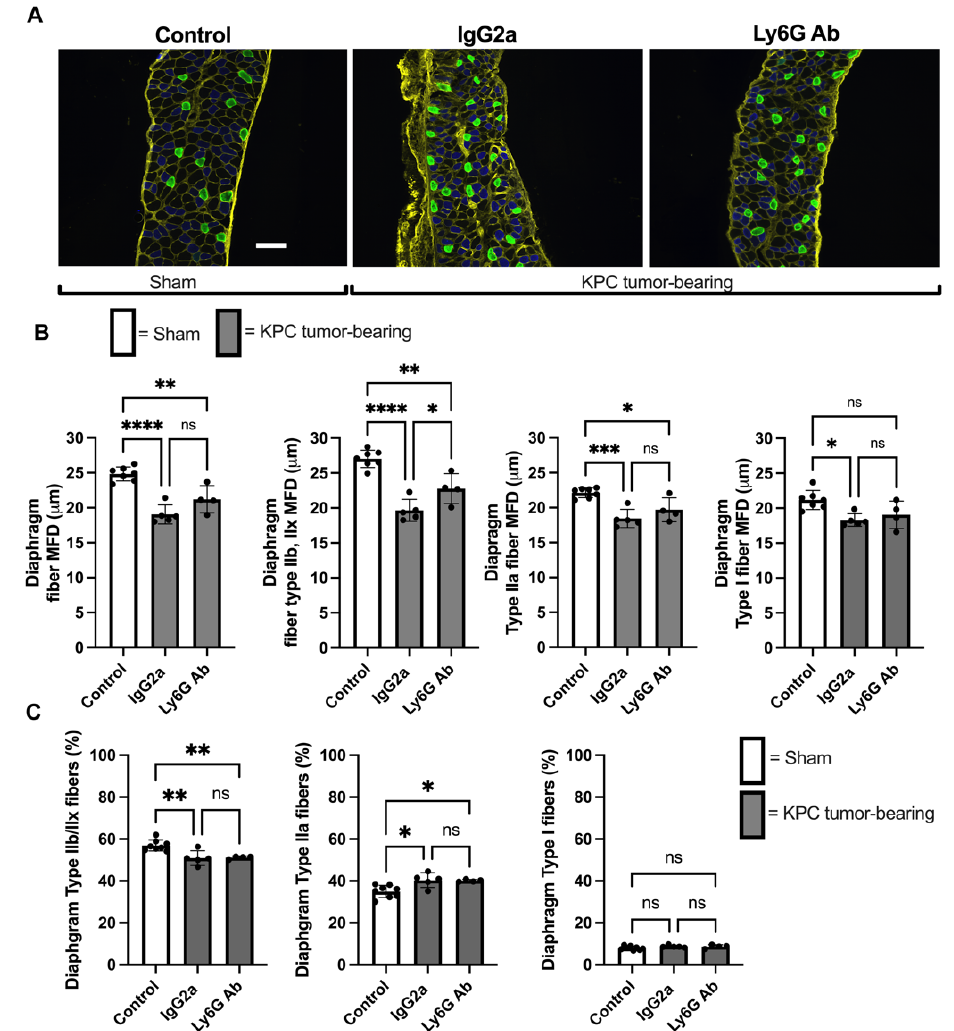
Figure 6. Depletion of Ly6G+ cells protects against Type IIx/b muscle fiber atrophy within diaphragm muscles of KPC mice. ( A ) Representative images of diaphragm strips stained with WGA to label extracellular matrix (yellow), and antibodies against myosin heavy chain I (green) and MHC IIa (blue). Type IIb and IIx fibers were identified as unstained (black) fibers. ( B ) Quantification of average, and fiber type-specific muscle fiber size, based on measurement of the minimum Feret’s diameter (MFD). A minimum of 1000 randomly selected fibers were analyzed per mouse. * p < 0.05; ** p < 0.01; *** p < 0.001; **** p < 0.0001; ns = not significant ( p > 0.05). Control: n = 8; IgG2a n = 5; Ly6G Ab: n = 4. Scale bar = 100 μ m. ( C ) Fiber-type proportions in diaphragm muscles from Sham control mice, and KPC tumor-bearing mice. A minimum of 1000 randomly selected fibers were analyzed per mouse. * p < 0.05; ** p < 0.01; ns = not significant (p > 0.05).